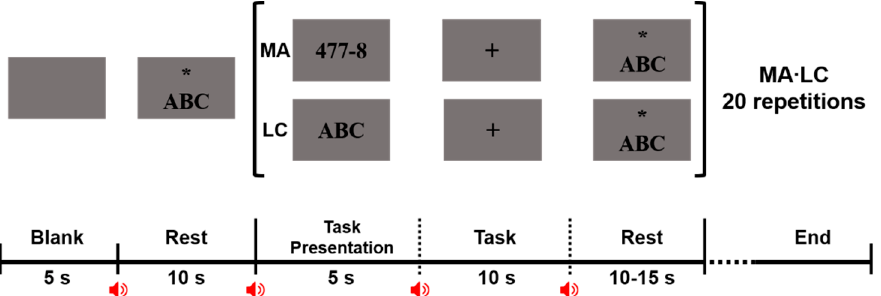
Figure 2. Experimental paradigm of one session used in the main experiment. In the beginning of each session, a rest period of 10 s is performed. The string ‘ABC’ and an asterisk are presented to indicate a rest period and the subject is asked to fix the eyes to the asterisk to minimize ocular movement. After the rest period, either mental arithmetic (MA) or light cognitive (LC) task is randomly performed. For MA, a pair of a three-digit number and a single-digit number between 5 and 9 is randomly presented, and the subject is asked to sequentially subtract the single-digit number from the three-digit number (e.g., 477 − 8) for 10 s. For LC, the string ‘ABC’ is presented, and the subject is asked to internally imagine vocalization of the English alphabet from A to Z with a 1 Hz speed for 10 s. Both MA and LC are performed ten times in each session, and each subject completes five sessions (50 MA and 50 LC in total). A short beep (300 ms) is presented at every screen transition (red speaker icons).